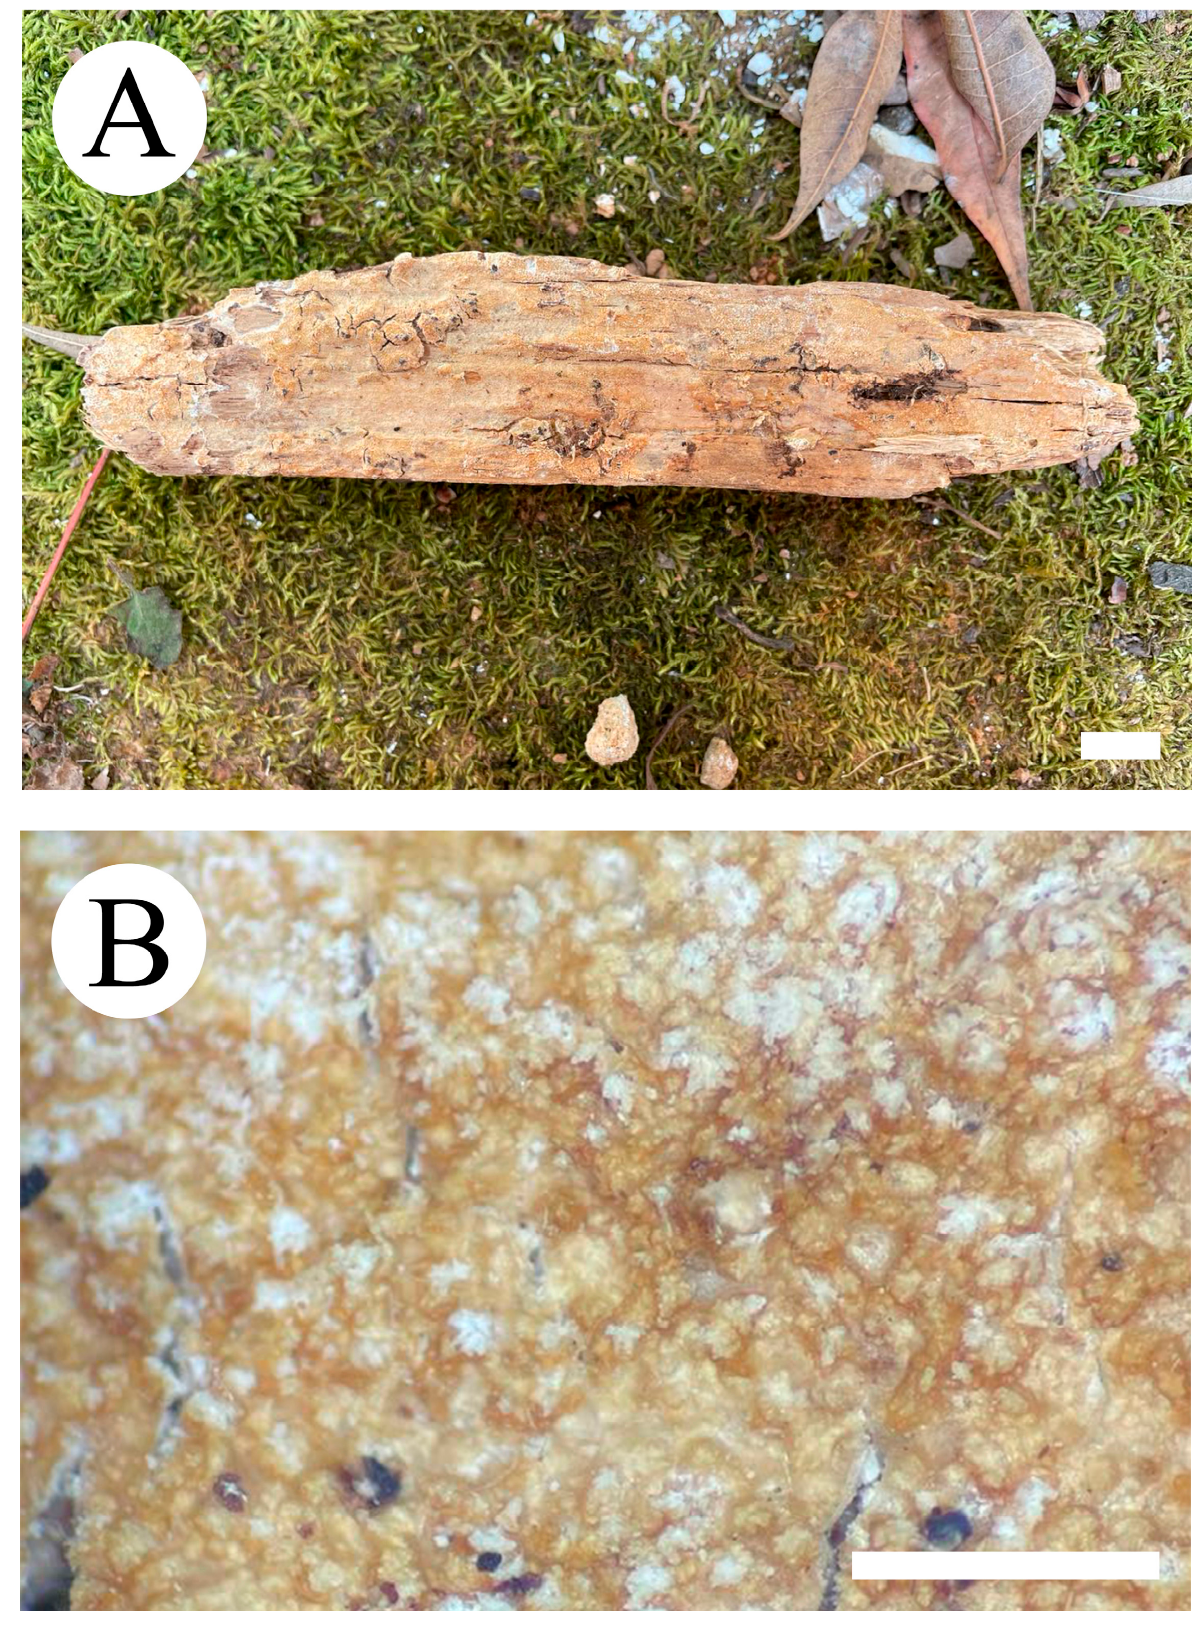
Figure 9. Basidioma of Merulius sinensis (CLZhao 2562, holotype). Bars: ( A ) = 1 cm, ( B ) = 1 mm.